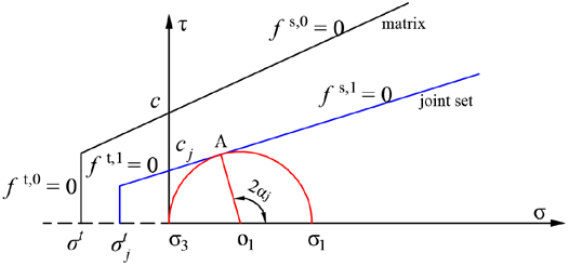
Figure 5. Mohr-Coulomb failure criterion with tension cut-off for matrix and joint.